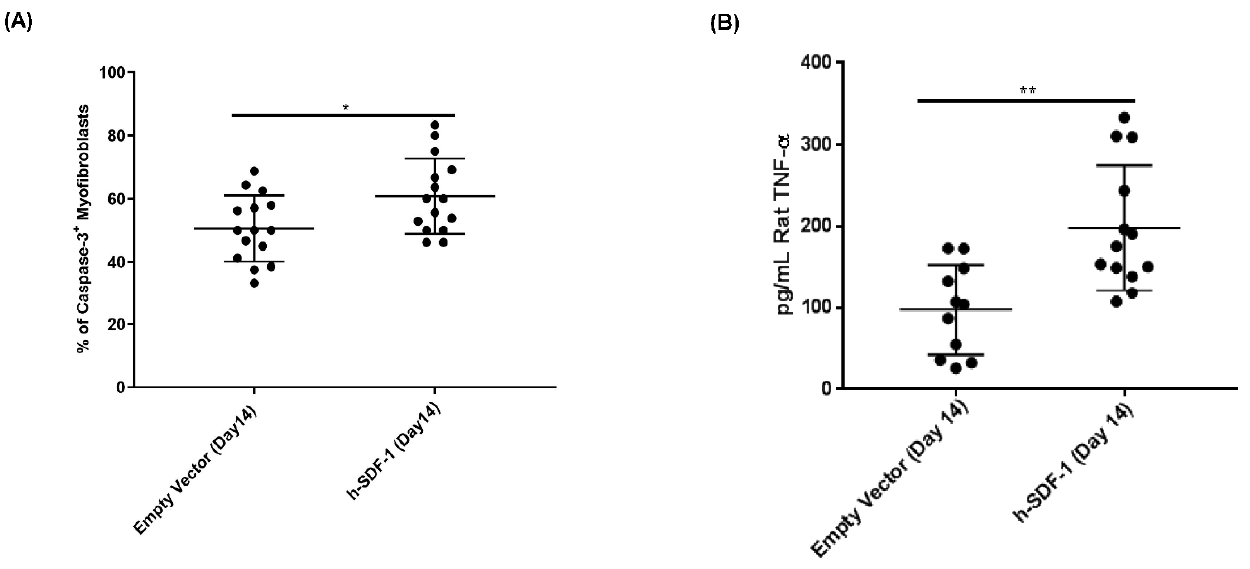
Figure 4. Effect of h-SDF-1 transfection on collagen producing cells in vivo. pSDF-1 gene transfer to bleomycin-injured rat lung reduced percentage of myofibroblasts ( A ) and collagen-producing cells ( B ), in accordance the volume of collagen fibrils in the parenchymal tissue was also reduced ( C ), compared to control animals. ( n = 15; Mean ± SD; *: p < 0.05, ****: p < 0.0001). (1 animal in h-SDF-1 group died ( n = 14)). ( n = 10) for stereological analysis ( C ). 3.5. pSDF-1 β Overexpression Induces Apoptosis in the Myofibroblasts in the Bleomycin-Injured rAT Lung Caspase 3-dependent apoptosis in myofibroblasts is induced in pSDF-1 treated group compared to the EV group (60.83 ± 11.92% vs. 50.6 ± 10.49%), (Figure 5A). Interestingly, level of TNF- α was significantly increased after SDF-1 β transduction 198.50 ± 21.26 pg/mL vs. 97.89 ± 16.69 pg/mL in the empty vector control group (Figure 5B).